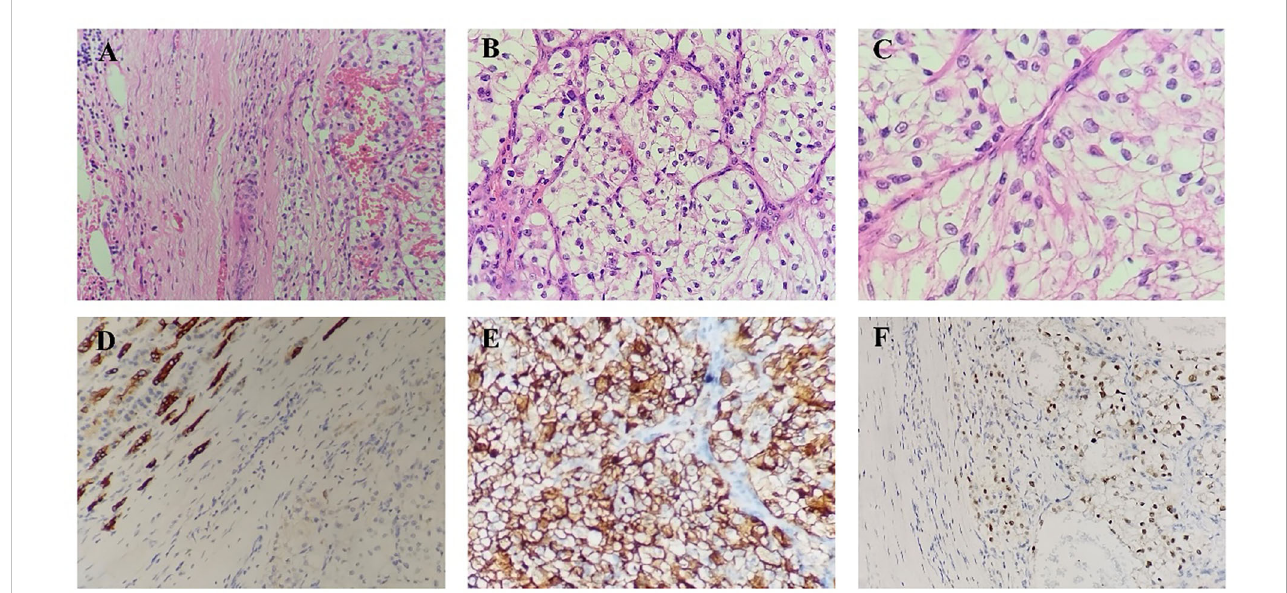
FIGURE 2 (A – C) . Microscopic picture with hematoxylin and eosin staining showing the renal cell carcinoma within the pancreatic tissue. (D) . Immunohistochemistry staining of the resected lesion from the pancreas, showing positive CK. (E) . Immunohistochemistry staining of the resected lesion from the pancreas, showing positive CD10. (F) . Immunohistochemistry staining of the resected lesion from the pancreas, showing positive